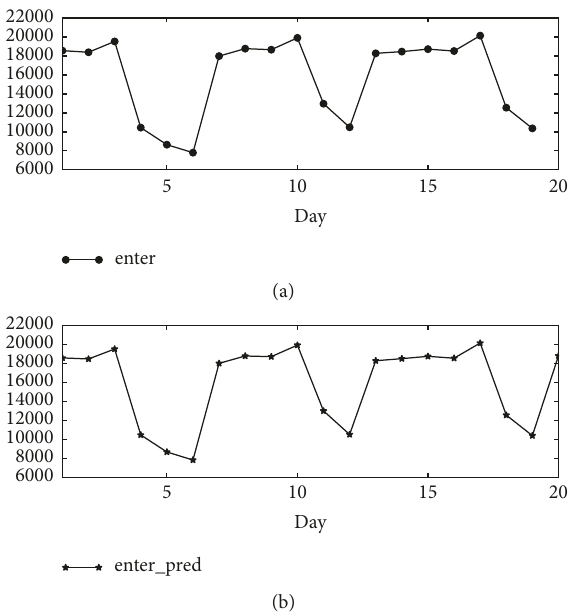
Figure 6: Prediction of daily exit passenger flow of Dabaishu rail transit station (2 hidden layers).